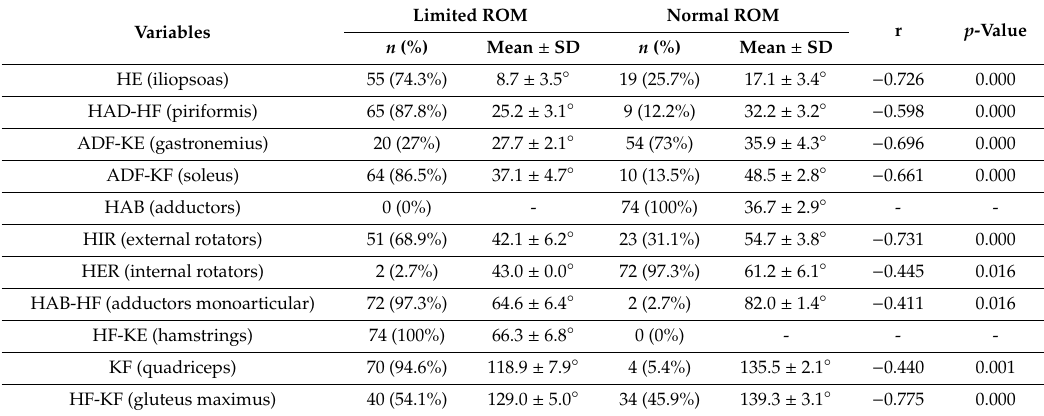
Hip extension test; HAD-HF: hip adduction with hip flexed 90 ◦ extended test; ADF-KE: ankle dorsiflexion with knee extended test; ADF-KF: ankle dorsiflexion with knee flexed test; HAB: hip abduction test; HIR, hip internal rotation test; HER: hip external rotation test; HAB-HF: hip abduction with hip flexed 90 ◦ test; HF-KE: hip flexion with knee extended test; KF: knee flexion test; HF-KF, hip flexion with knee flexed